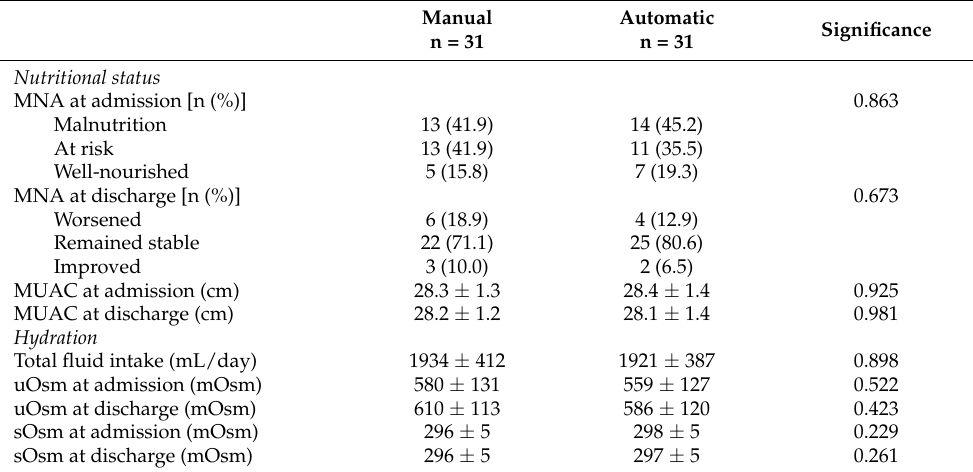
Table 3. Nutrition and hydration biomarkers of the included acute-stroke patients (n = 62) in the manual and automatic flushes pumps groups. Means ± standard deviations and